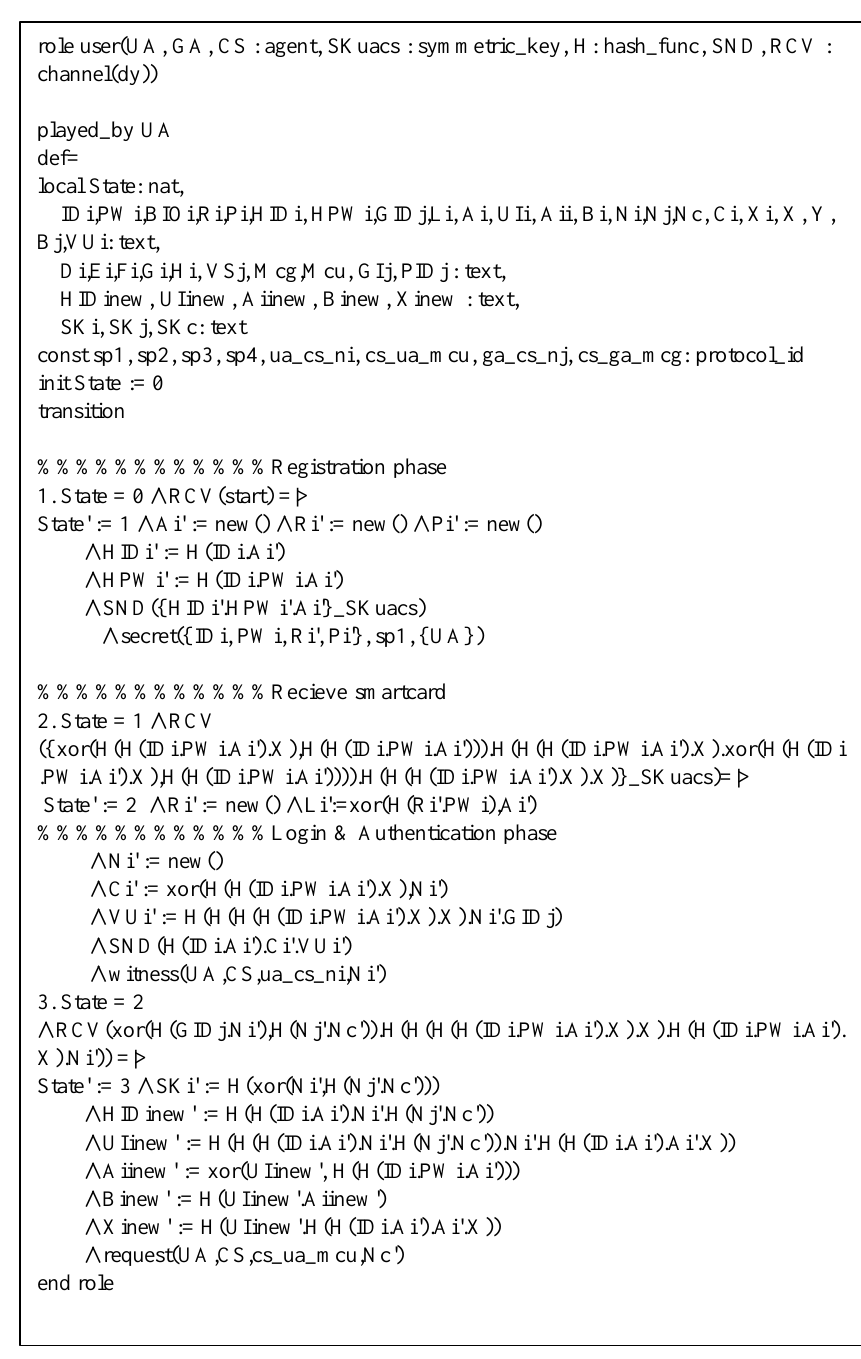
Figure 9. Specification of